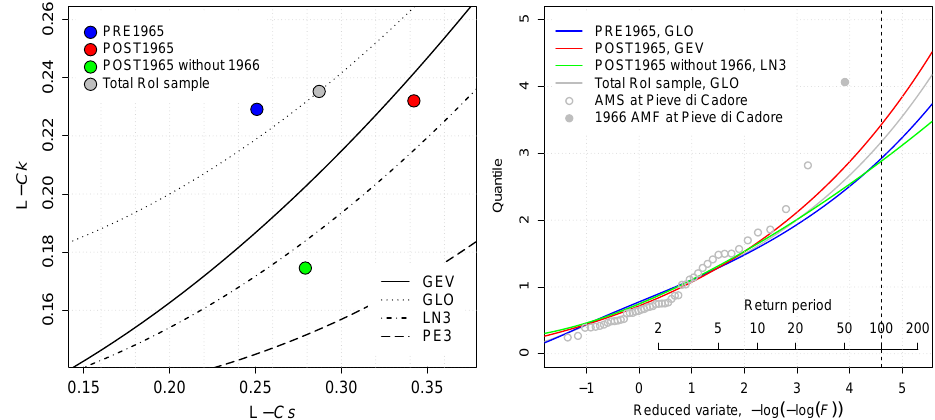
Figure 5. Left: L-moment ratio diagram for three-parameter distributions. Blue, red, green and grey points represent the record length weighted average of L-Cv and L-Cs for PRE1965, POST1965 and POST1965 without 1966 RoI sub-samples and total RoI sample, in this order. Right: dimensionless growth-curves associated with the above mentioned four sub-samples. The choice of the corresponding three- parameter distribution was made by applying Hosking and Wallis test (see Hosking and Wallis, 1993). Grey points indicate the empirical growth-curve for Pieve di Cadore (see Fig. 1, the full coloured point is the 1966 annual maximum flood).